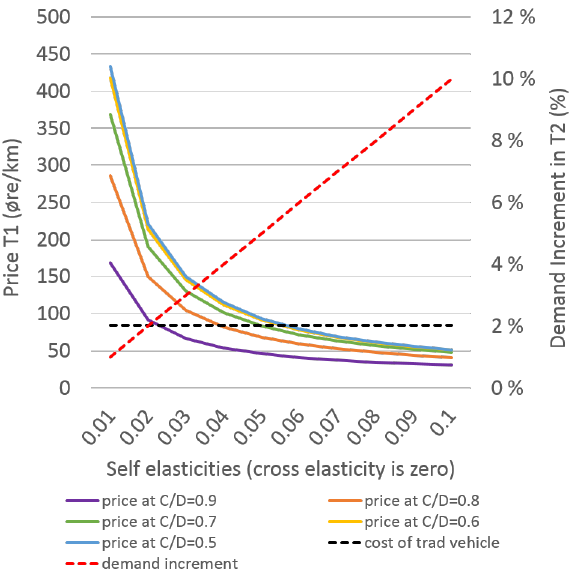
Figure 5. Effect of the self-elasticity on the price increase in time-step T 1 and comparison with the cost of a traditional diesel